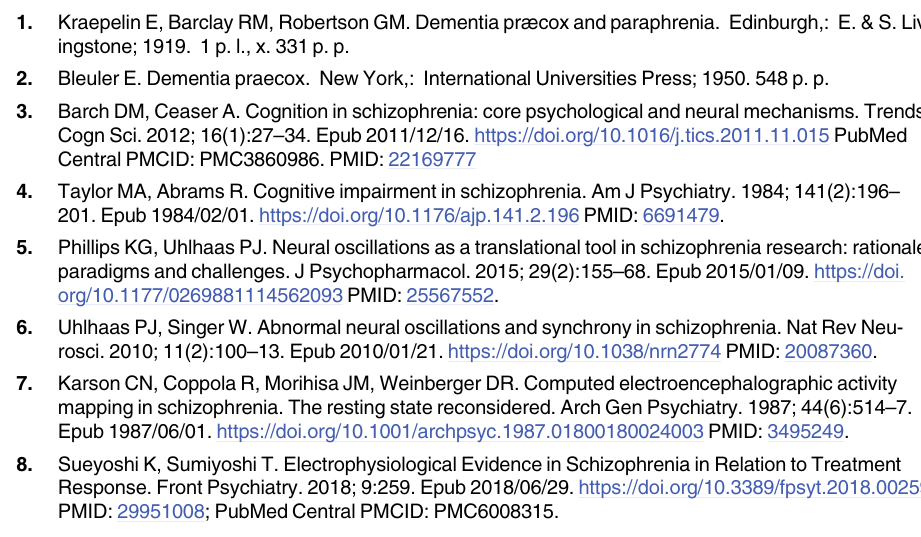
S1 Table. 19 microstate features obtained for patients diagnosed with schizophrenia and healthy (control) subjects. S2 Table. Classification accuracies obtained using microstate and conventional EEG fea- tures obtained from the EEG dataset for patients diagnosed with schizophrenia and healthy (control) subjects. S3 Table. Classification accuracies achieved for different methods of selecting features from an EEG dataset for patients diagnosed with schizophrenia and healthy (control) sub-